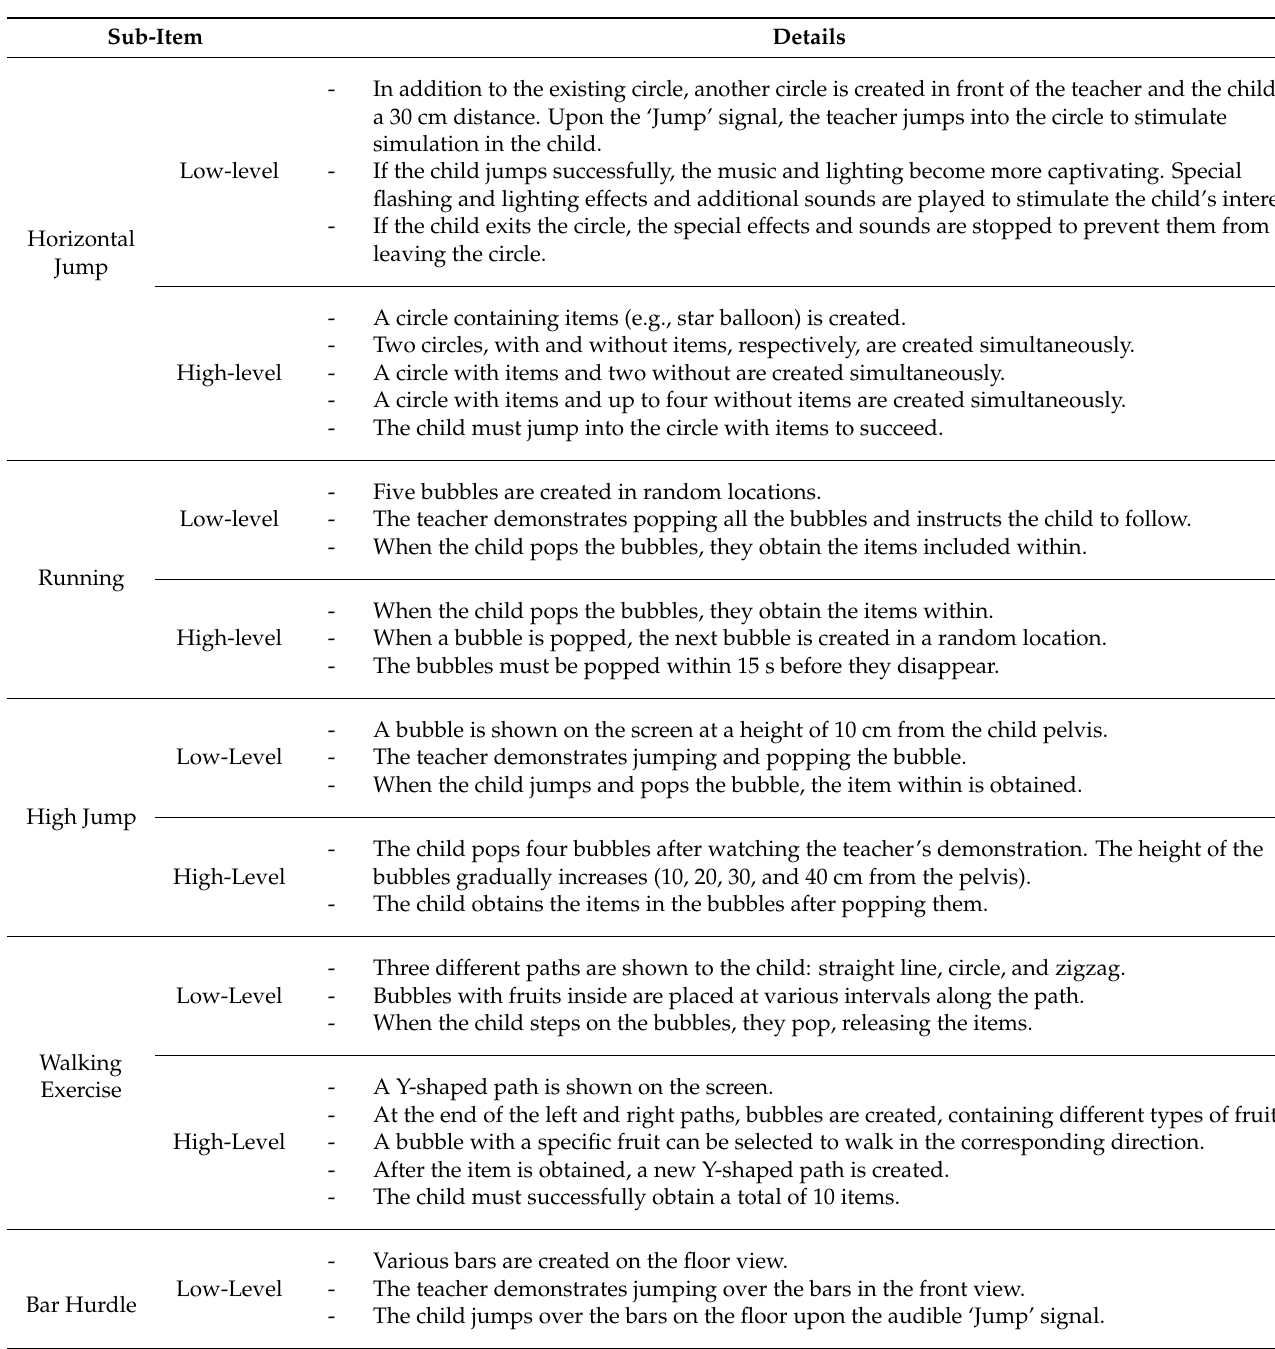
Table 8. Descriptions of VR exercise program for each